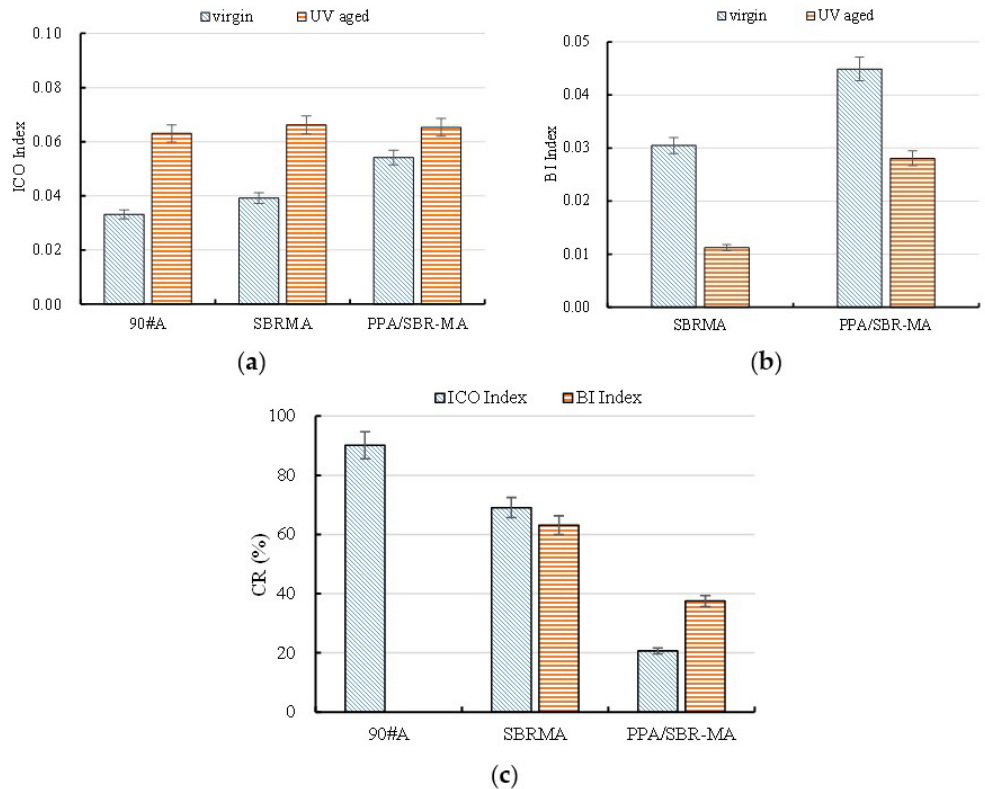
Figure 10. Chemical structure index of the three asphalts. ( a ) Carbonyl index; ( b ) SBR index; ( c ) Chemical structure aging